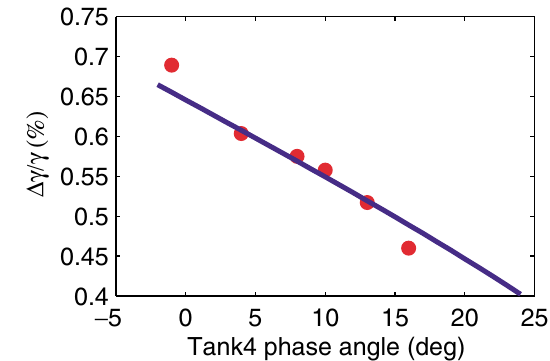
FIG. 14. (Color) FWHM energy chirp of the electron beam as a function of the tank 4 phase. The blue curve is calculated and the red dots are measured.